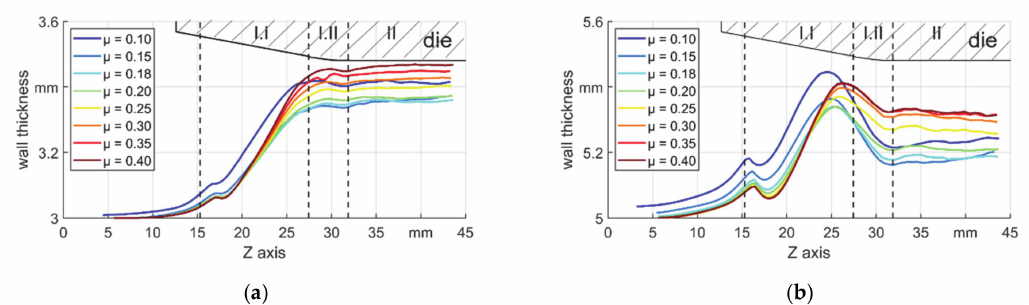
Figure 9. Wall thickness developments, ( a ) s 0 = 3 mm and ( b ) s 0 = 5 mm.